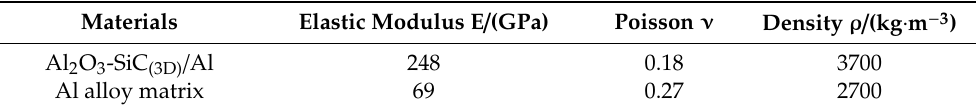
Table 1. Properties of brake disc material.